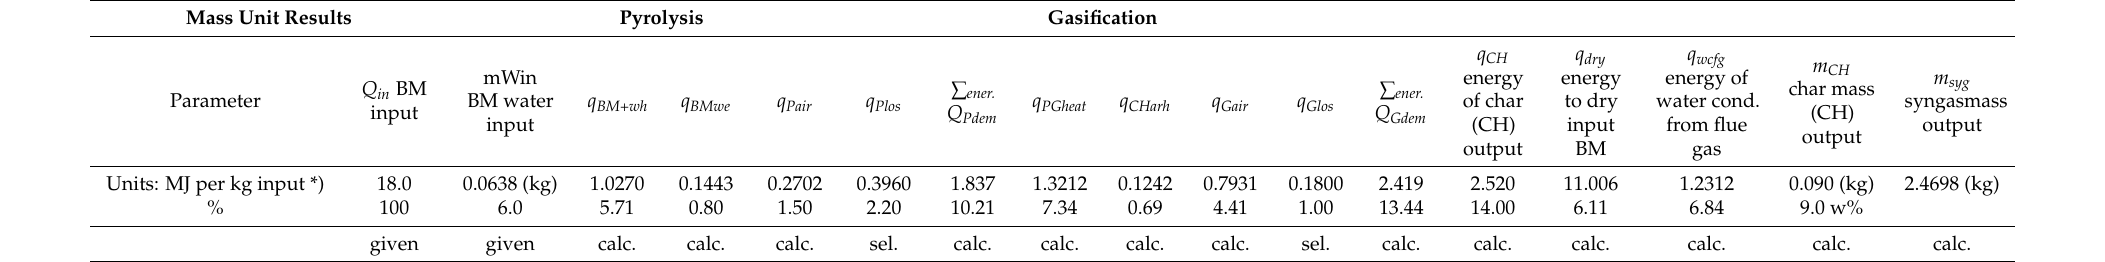
Table 2. Heat balance of unit mass input model calculation and mass outputs—accurate data.